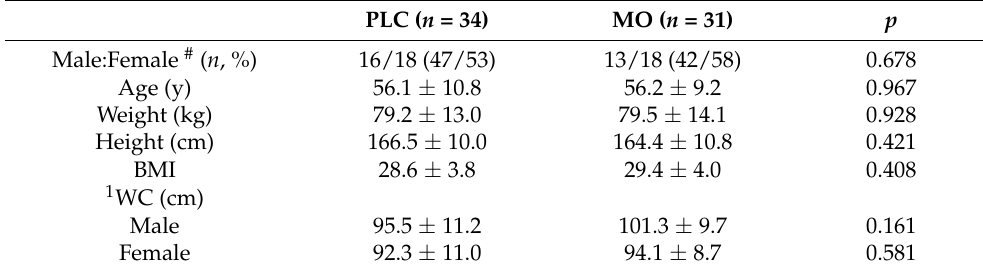
Table 1. Basal demographic and anthropometric characteristics.